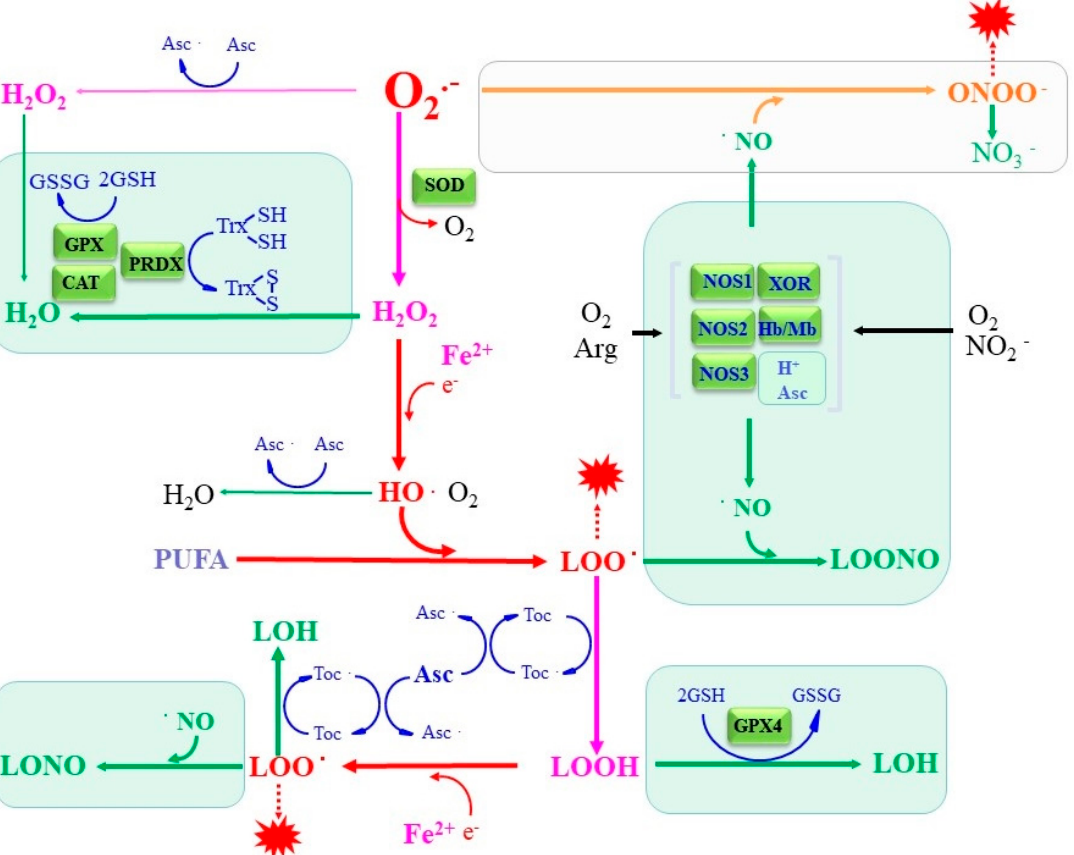
Figure 5. The interaction between ROS/lipid radicals with antioxidants in vivo. Detoxification reactions performed by representative antioxidative enzymes and low molecular weight antioxidants are presented in green. In addition to antioxidative enzymes, Toc, Asc, and NO can terminate radical chain reactions, which result in the suppression of ferroptosis.